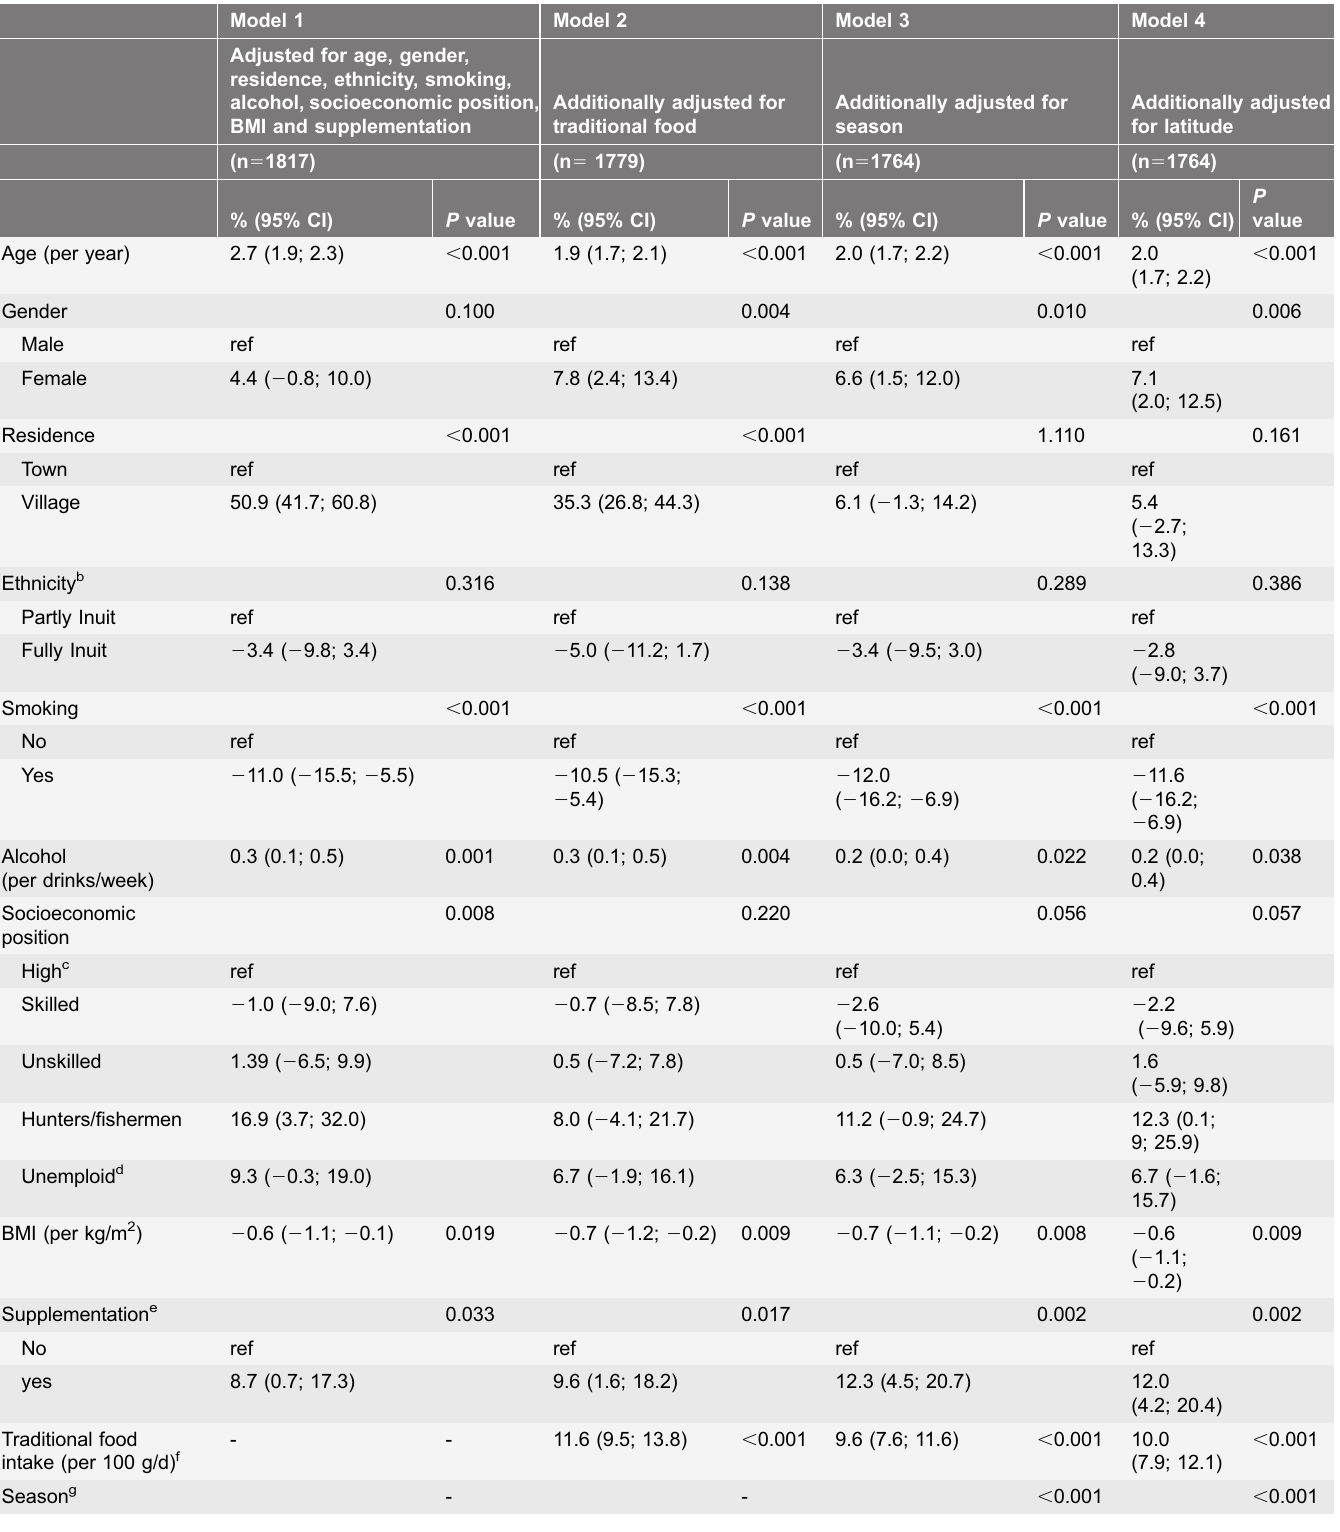
Table 3. Predictors of serum 25(OH)D3 (nmol/L) expressed as percentage change per defined unit change in the explanatory variable a